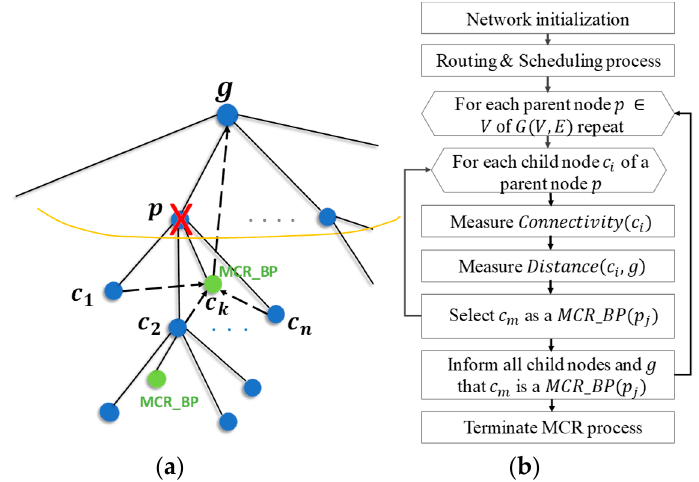
Figure 4. MCR back-up parent selection procedure. ( a ) Segment of a network where the primary parent failed; ( b ) MCR _ BP selection procedure.